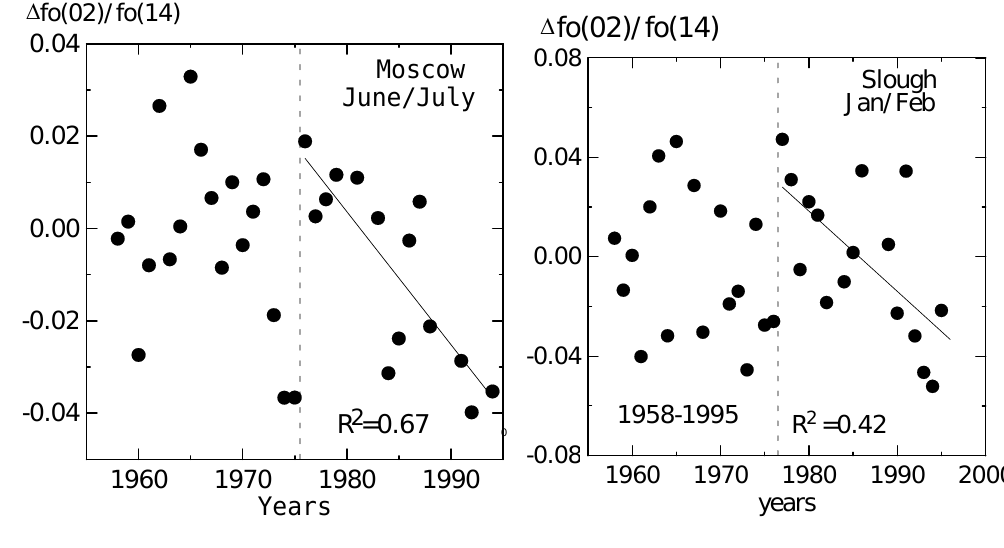
Fig. 11. Time behavior of 1 fo F2(02)/ fo F2(14) for Moscow and Slough.